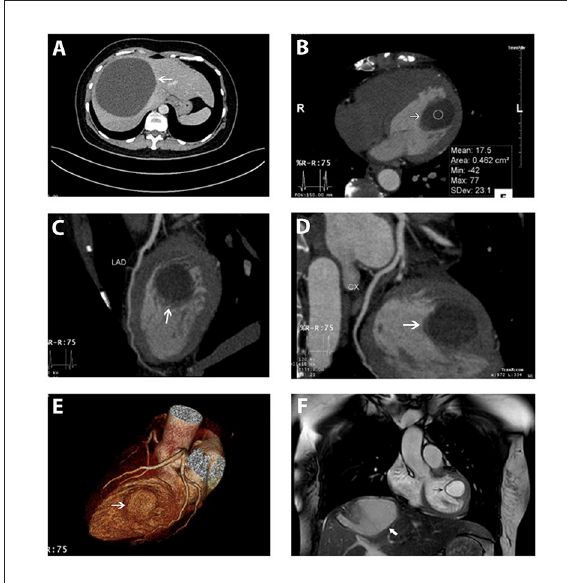
FIGURE2 Hepatic cyst and the cardiac cyst on CT and on MRI. (A) A giant hepatic cyst was seen on the abdominal CT scanner (white arrow). (B–E) An encapsulated, rounded, and fluid-attenuated non-calcified structure along the LV lateral wall (white arrow) and its spatial relationship with coronary arteries (left anterior descending, circumflex) on MDCT. (F) Cardiac cyst (black arrow) and the hepatic cyst (white arrow) were simultaneously depicted on MRI. The cardiac cyst was a single intramuscular cyst located at the anterolateral papillary muscle attached to the LV lateral free wall, protruding into the LV cavity, not enhanced by the gadolinium. Myocardial perfusion and enhancement were normal.